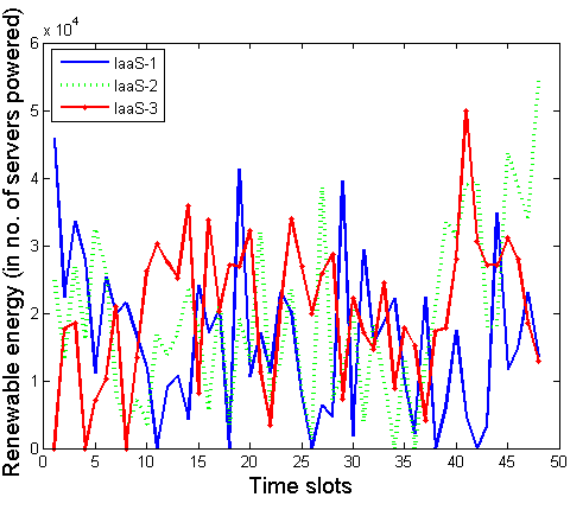
Figure 4. Renewable energy data used in the simulation. Electronics 2016 , 5 , 65